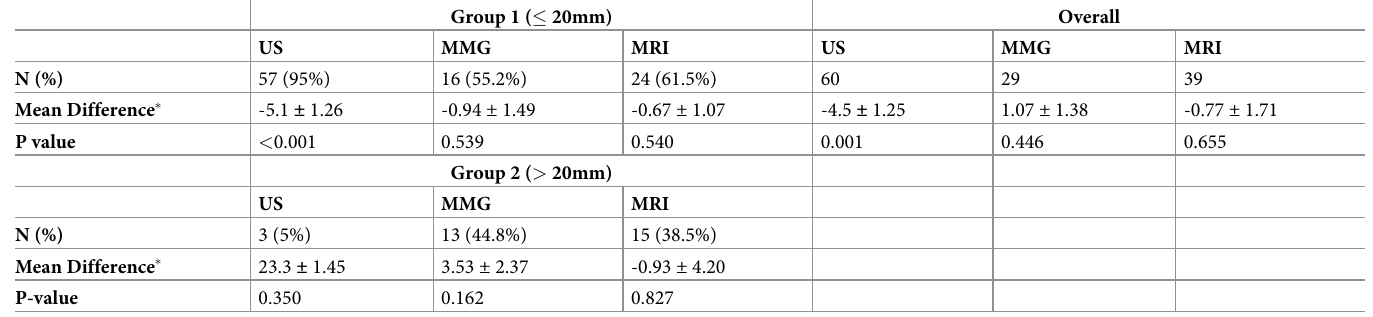
Table 5. Comparison of tumour size by modality versus